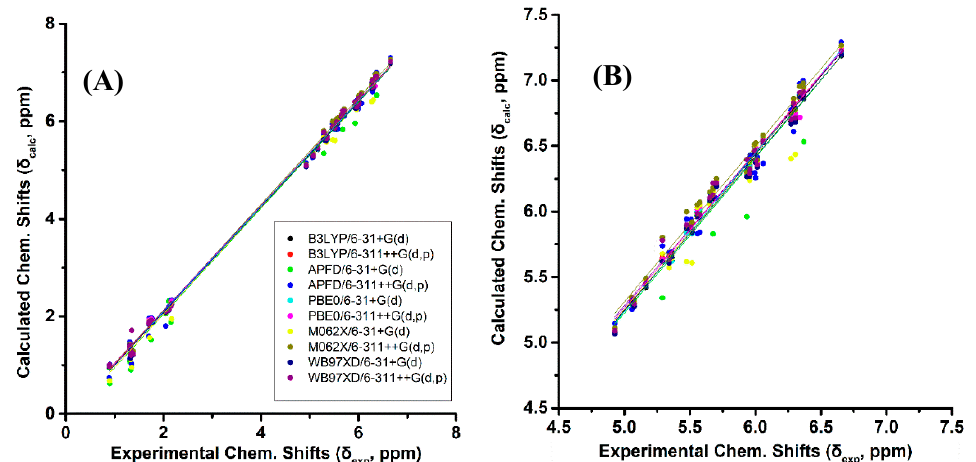
Figure 2. ( A ) Calculated, δ calc , 1 H-NMR chemical shifts (at the GIAO / B3LYP / 6-311 + G(2d,p) level of theory with CPCM in CHCl 3 / CH 3 CN) vs. experimental, δ exp , chemical shifts with energy minimization using various functionals and basis sets for ( Z )-1,3-pentadiene, ( E )-1,3-pentadiene, ( E , Z )-2.4-hexadiene, ( E , E )-2,4-nonediene, ( Z , Z )-2,4-nonediene, ( E , Z )- 2,4-nonediene, and ( Z , E )-2,4-nonediene (Figure 1). ( B ) Calculated, δ calc , 1 H-NMR chemical shifts of the olefinic protons vs. experimental, δ exp , chemical shifts of the data of Figure 2A.